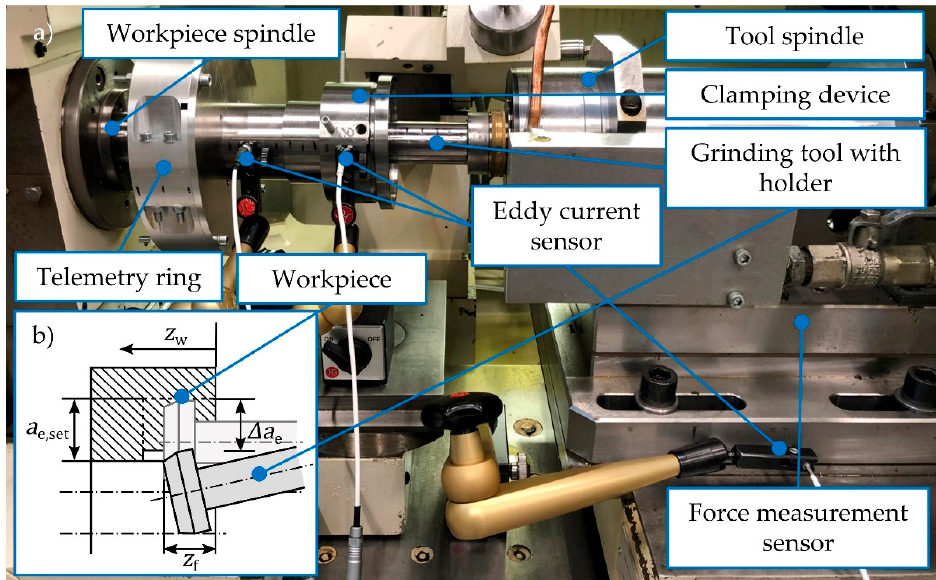
Figure 2. ( a ) Experimental setup to measure the spindle compliance in a laboratory environment with piezoelectric force measurement and eddy current sensors to measure the deflection of spindle systems. ( b ) Reduction of total radial stock removal 𝑎 (cid:2915),(cid:2930)(cid:2925)(cid:2930) by ∆𝑎 (cid:2915) [35].